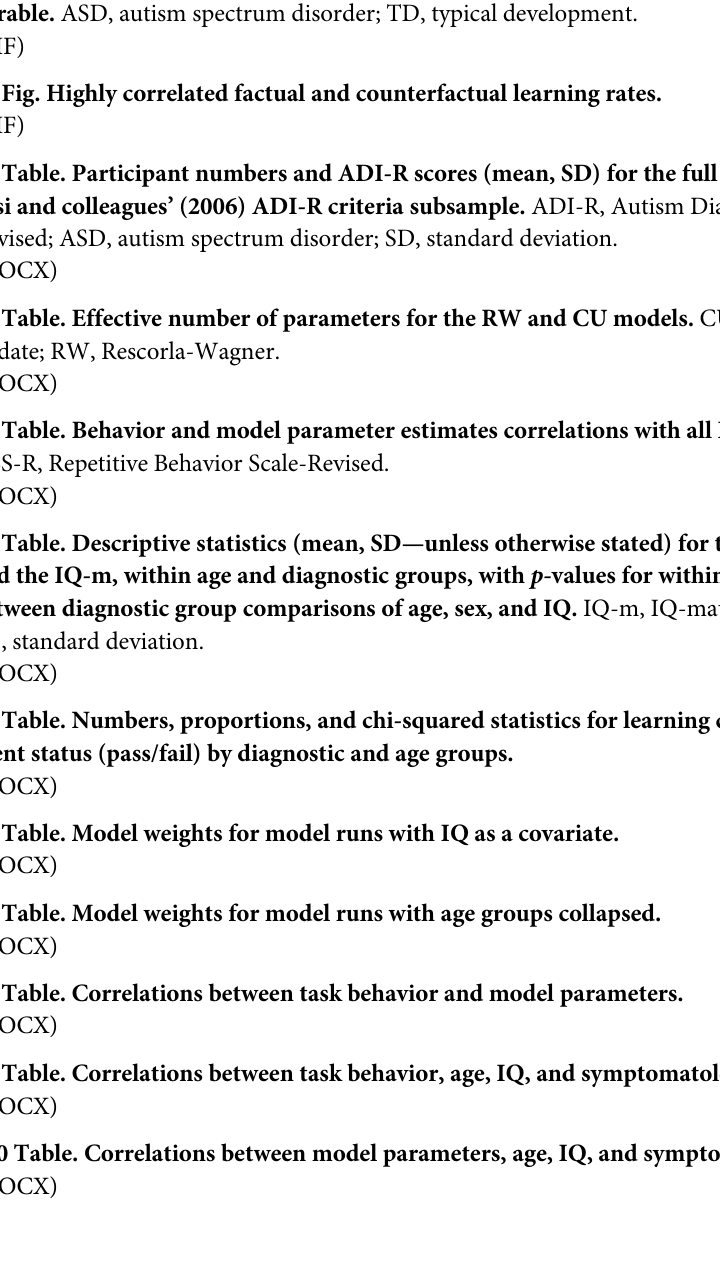
S6 Fig. Simulation showing a larger value difference for a higher reward learning rate (TD) than a lower reward learning rate (ASD), when punishment learning rates are com- parable. ASD, autism spectrum disorder; TD, typical development. S7 Fig. Highly correlated factual and counterfactual learning rates. S1 Table. Participant numbers and ADI-R scores (mean, SD) for the full ASD sample and Risi and colleagues’ (2006) ADI-R criteria subsample. ADI-R, Autism Diagnostic Interview- Revised; ASD, autism spectrum disorder; SD, standard deviation. S2 Table. Effective number of parameters for the RW and CU models. CU, counterfactual update; RW, Rescorla-Wagner. S3 Table. Behavior and model parameter estimates correlations with all RBS-R subscales. RBS-R, Repetitive Behavior Scale-Revised. S4 Table. Descriptive statistics (mean, SD—unless otherwise stated) for the full sample and the IQ-m, within age and diagnostic groups, with p- values for within-age group, between diagnostic group comparisons of age, sex, and IQ. IQ-m, IQ-matched subsample; SD, standard deviation. S5 Table. Numbers, proportions, and chi-squared statistics for learning criterion attain- ment status (pass/fail) by diagnostic and age groups. S6 Table. Model weights for model runs with IQ as a covariate. S7 Table. Model weights for model runs with age groups collapsed. S8 Table. Correlations between task behavior and model parameters. S9 Table. Correlations between task behavior, age, IQ, and symptomatology. (DOCX) S10 Table. Correlations between model parameters, age, IQ, and symptomatology.